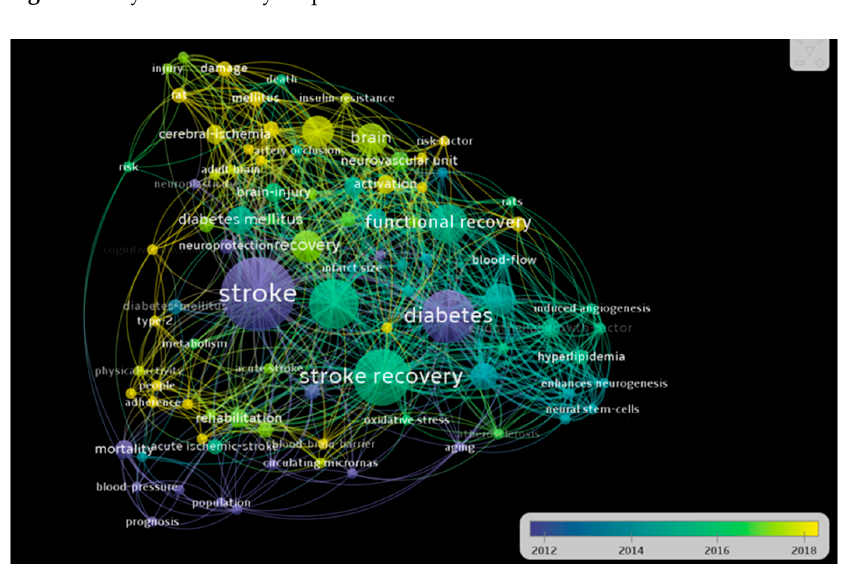
Figure 3. Keyword density map.